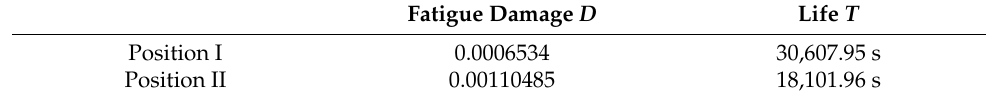
Table 6. Fatigue analysis results of 2D SiC/SiC stiffened plates with different meso-model positions.